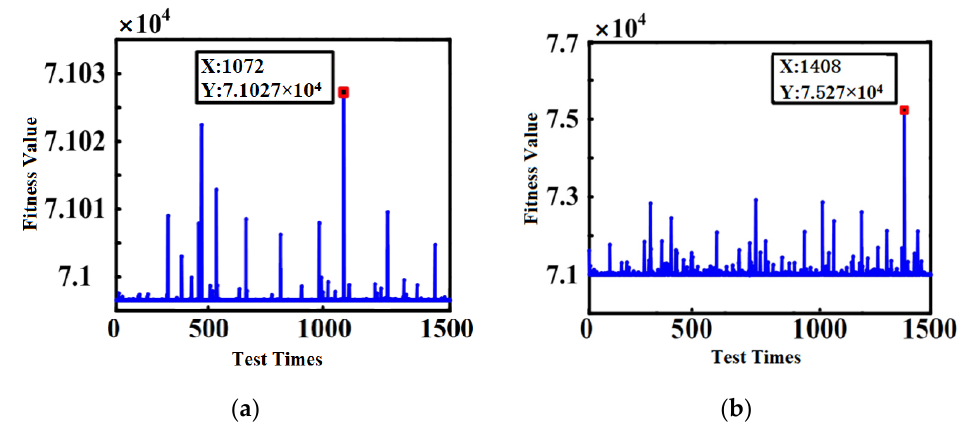
Figure 13. Comparison of fitness of linear and nonlinear inertial weight transformation methods. ( a ) Linear inertia weight change method; ( b ) non-linear inertia weight change method.